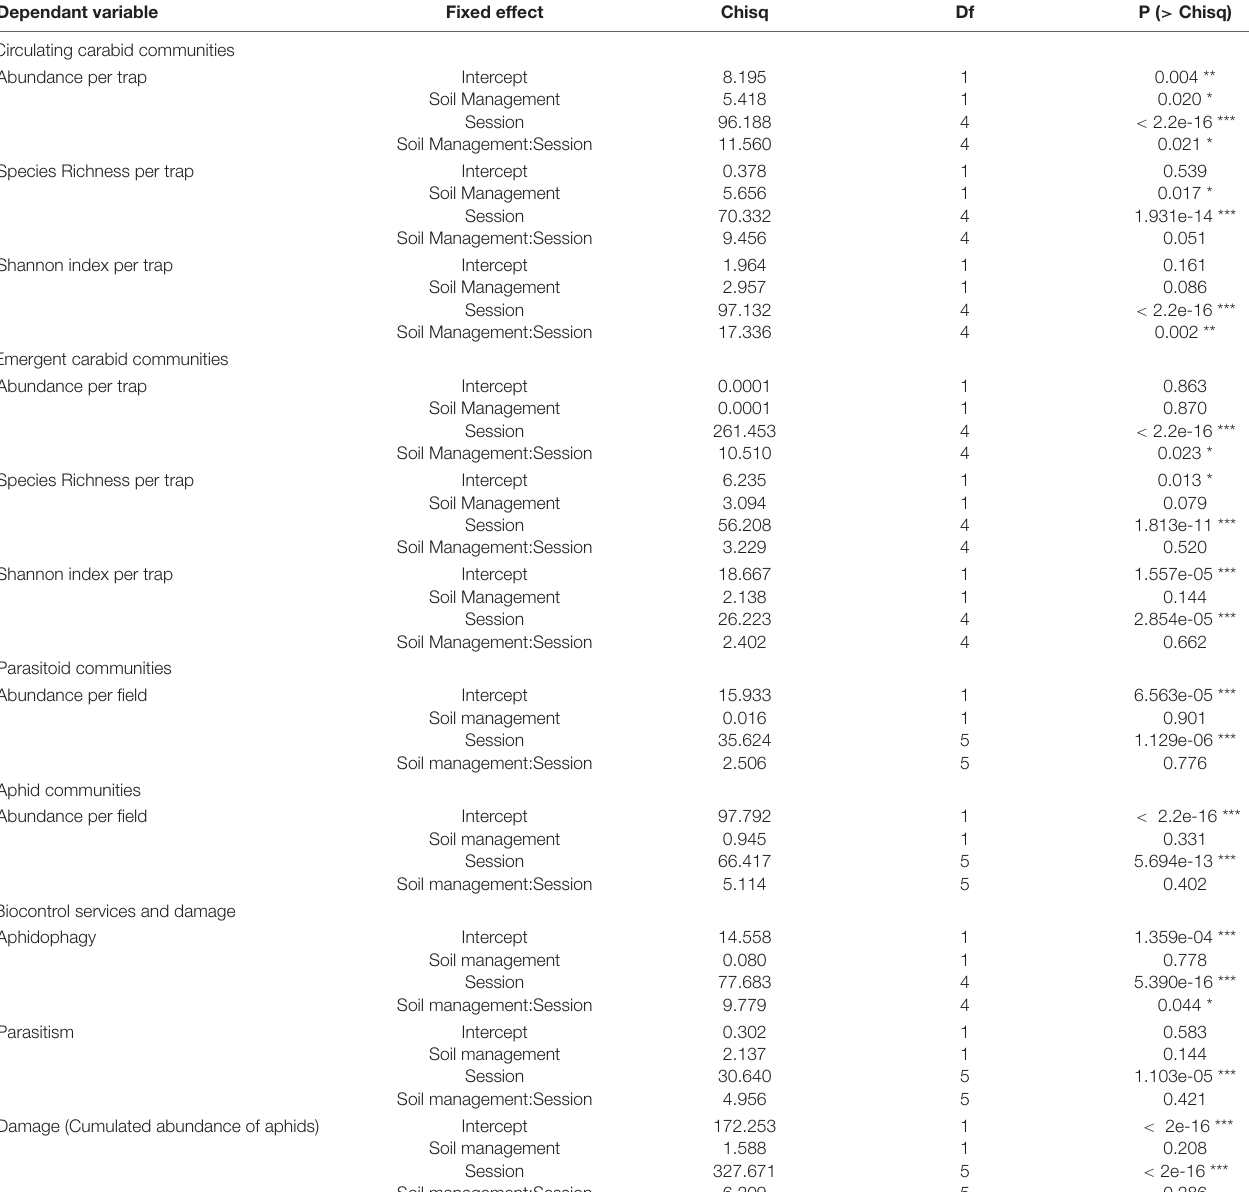
TABLE 1 | Deviance table for the effect of soil management, sampling session and their interaction on arthropod communities, their ecosystem services and damage. Dependant